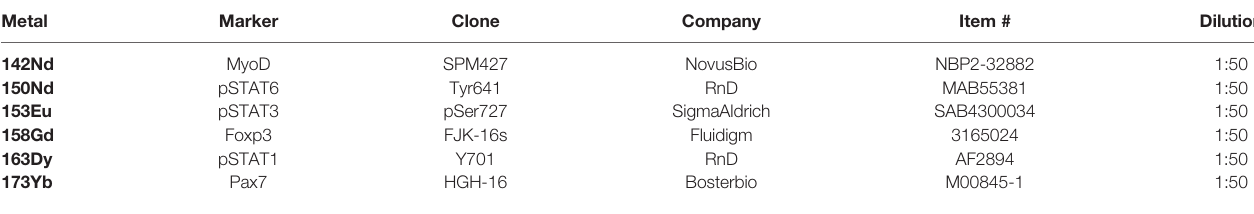
TABLE 2 | Antibodies used for intracellular staining of mass cytometry samples. Metal